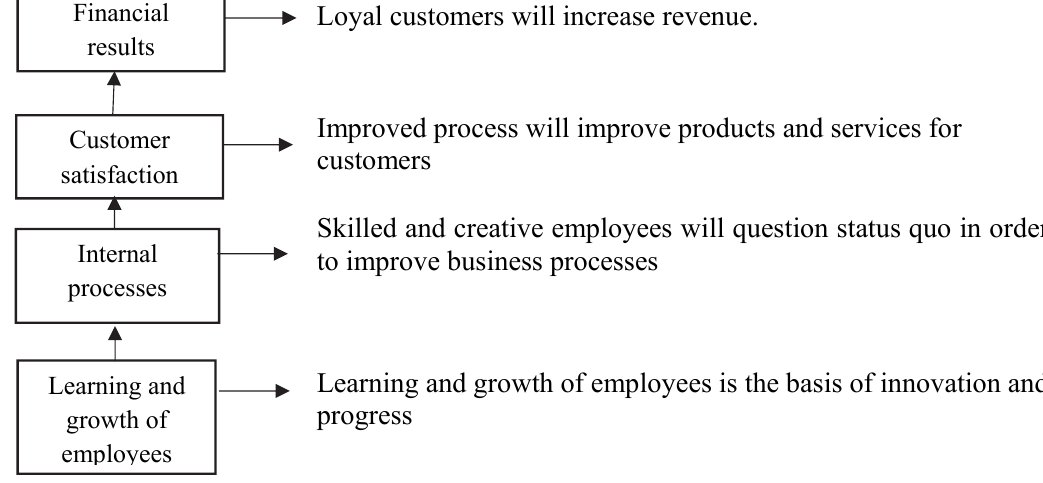
Fig. 1. Analysis of the relationship between the four dimensions of BSC (Kaplan & Norton,